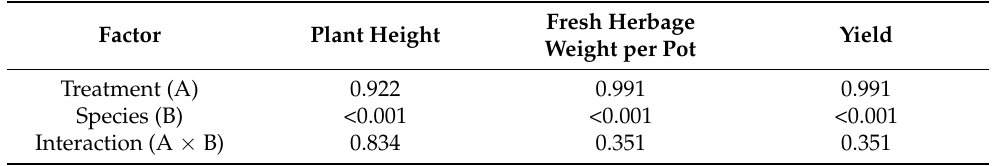
Table 1. p -Value of ANOVA for plant height, fresh herbage weight, and yield in the analyzed herb species. Fresh Herbage Factor Plant Height Yield Weight per Pot Treatment (A) 0.922 0.991 0.991 Species (B) <0.001 <0.001 <0.001 Interaction (A × B) 0.834 0.351